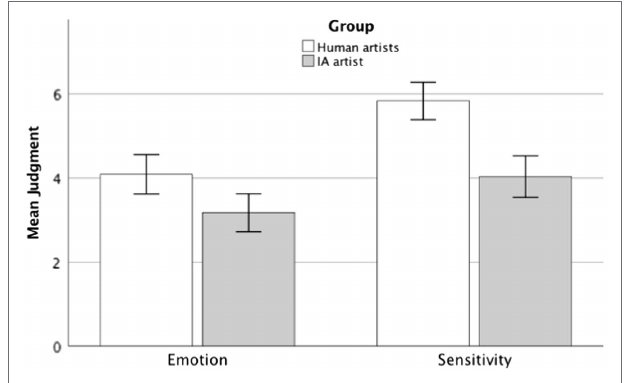
FIGURE 1 | Judgment of artists’ evoked emotion and sensitivity by group in experiment 1. Error bars represent 95%